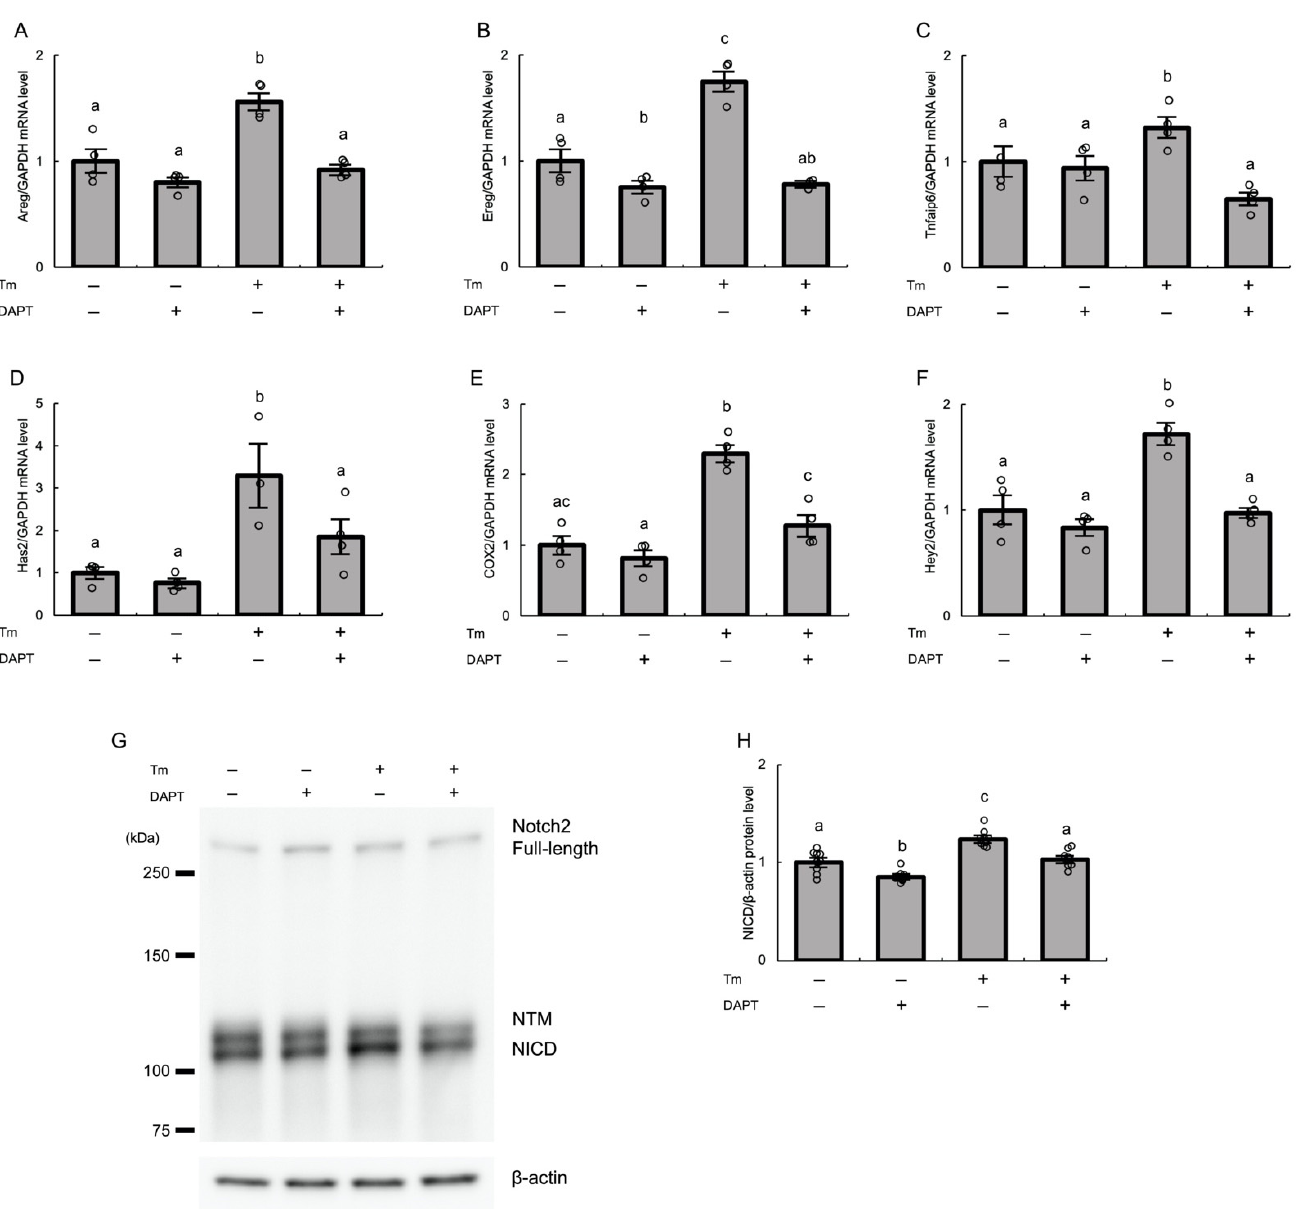
Figure 5. Notch2 signaling mediates ER stress-induced expression of various genes associated with COC expansion in cultured human GLCs. Human GLCs were incubated with tunicamycin (2.5 µg/mL) and DAPT (50 µM) in medium containing hCG (10 IU/mL). The expression levels of ( A ) Areg, ( B ) Ereg, ( C ) Tnfaip6, ( D ) Has2, ( E ) COX2, and ( F ) Hey2 mRNAs were measured by real-time PCR and normalized to that of GAPDH. ( G ) The protein expression level of an active form of Notch2 (Notch intracellular domain) in GLCs was analyzed by western blotting. β -Actin was used as a load- ing control. ( H ) Quantitative analysis of western blotting. Values represent means ± SEM, relative to the mean control value. The letters denote significant differences between groups. Tm, tunicamy- cin; NTM, Notch transmembrane domain; NICD, Notch intracellular domain.